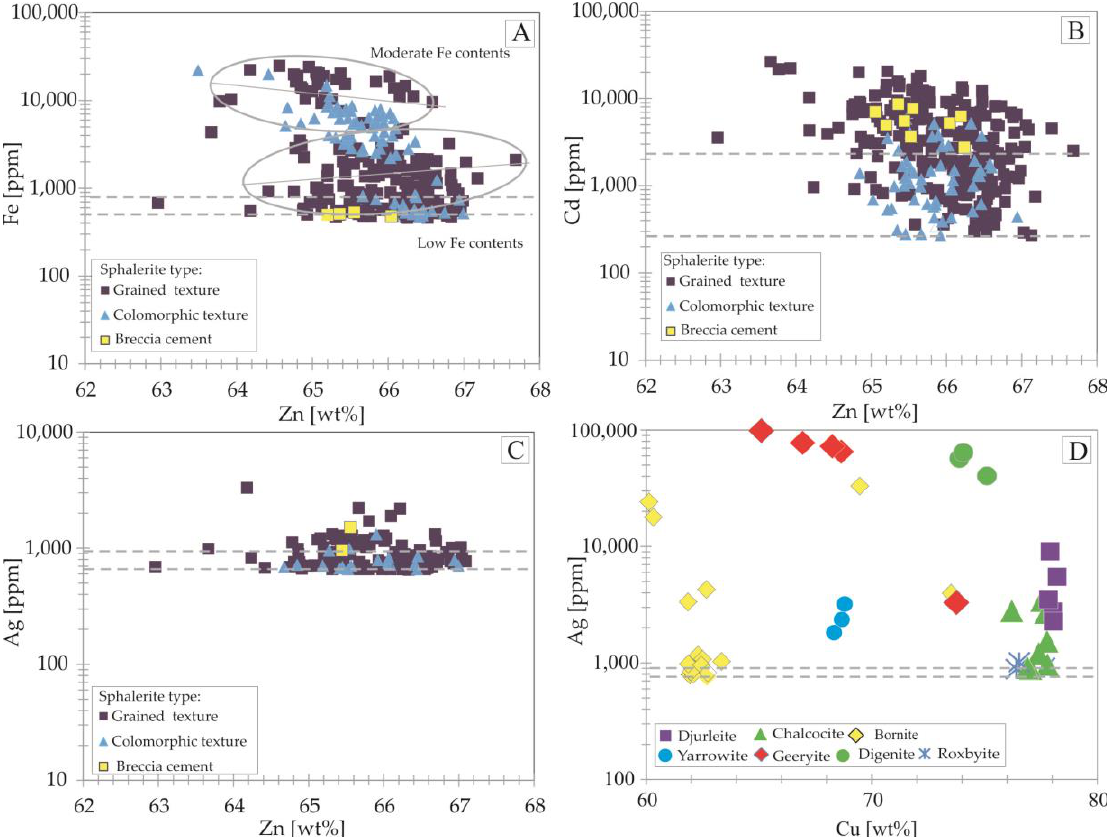
Figure 15. Bivariate trace element plots based on EPMA for sulfides minerals from Zn-Pb ( A – C ) and Cu-Ag ( D ) deposits, 0 values and values below low precision limits are not presented on the logarithmic axis. Note: horizontal grey dashed lines indicate the range of precision of measurements in the entire population for a given element. ( A ) Zn vs. Fe in sphalerite, ( B ) Zn vs. Cd in sphalerite, ( C ) Zn vs. Ag in sphalerite, and ( D ) Cu vs. Ag in Cu sulfides.